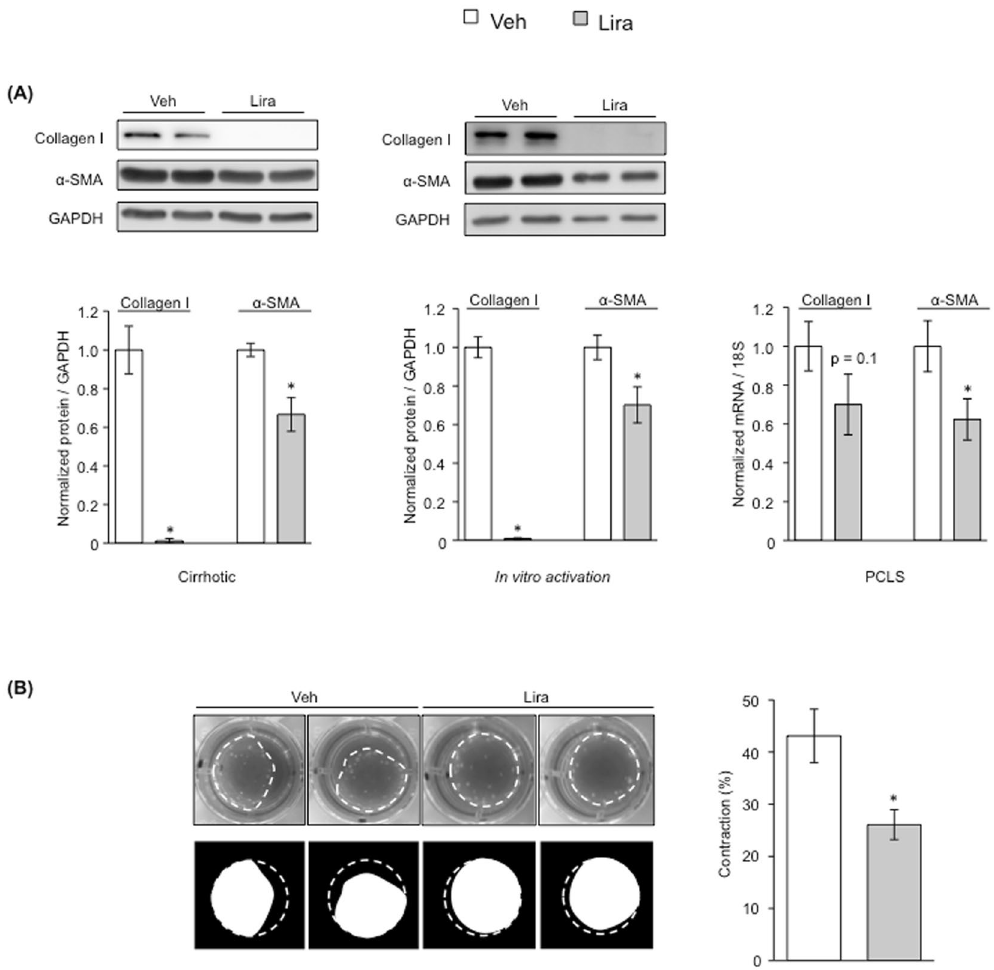
Figure 1. Amelioration of human primary HSC in response to liraglutide. (A) Expression of depicted proteins/ genes after in vitro treatment with 50 µ M liraglutide or vehicle in: 1-HSC isolated from cirrhotic human livers (left), 2-quiescent human HSC undergoing in vitro activation (middle), and 3-human precision-cut liver slices (PCLS) (right). (B) Effects of liraglutide, or its vehicle, on the contraction of primary human HSC. n = 3 per experimental condition. * p < 0.05 vs.